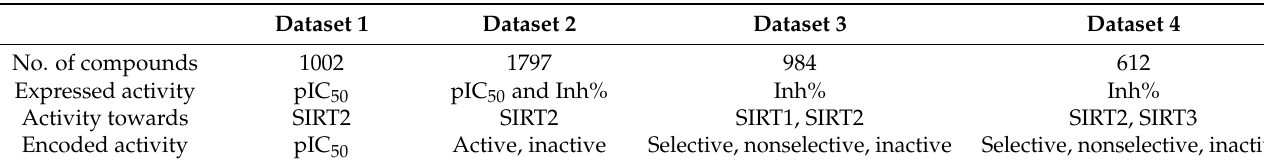
Table 1. Description of the